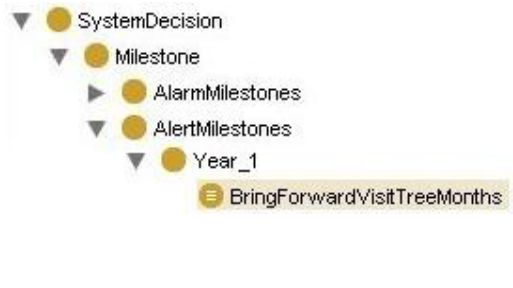
Figure 6. Inference in Protégé for questions about 2 month-old